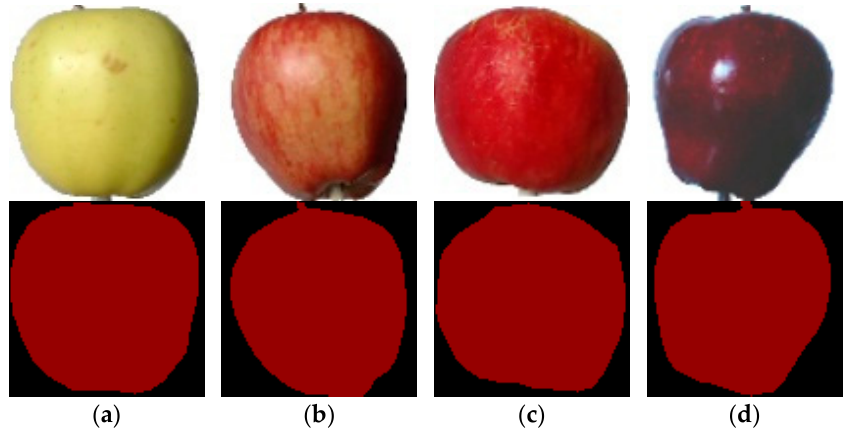
Figure 6. Images and labels of different apple varieties. ( a ) Golden Delicious. ( b ) Fuji. ( c ) Honey Crisp. ( d ) Red Delicious.